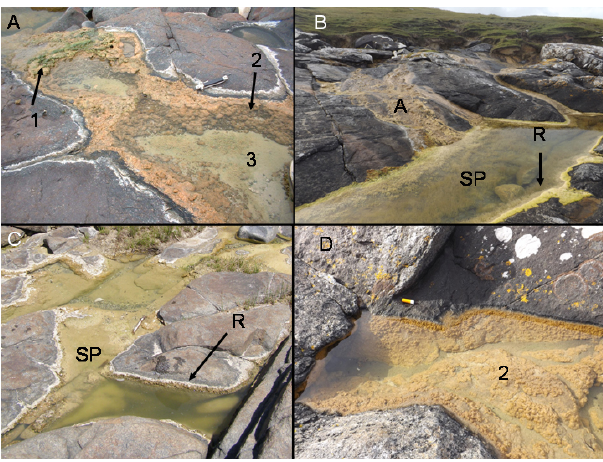
Figure 4. SPS mineral precipitated stromatolites. (a) Stromato- lite pool showing: pustular (1), laminar and columnar (2), and colloform (3) stromatolite types from Cape Morgan, South Africa. (b) Stromatolite pool (SP), stromatolite apron (A), and stromato- lite rim (R). (c) Joint controlled stromatolite pool (SP) and stro- matolites, and a stromatolite rim (R). Both (b) and (c) are from Luskentyre Bay, Harris, UK. (d) Stromatolite pool from Mtentu, South Africa.